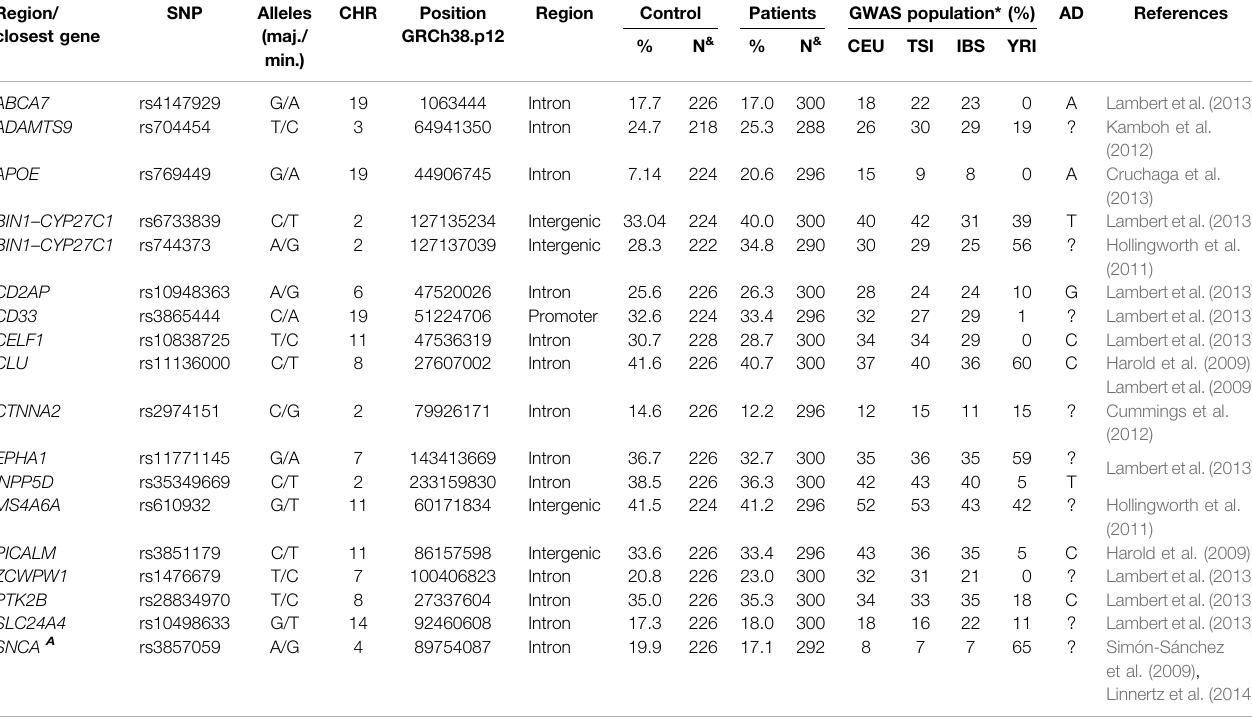
TABLE 2 | Single-nucleotide polymorphisms (SNPs) selected for this study and their minor allele frequencies. Region/ SNP Alleles closest gene (maj./ min.)